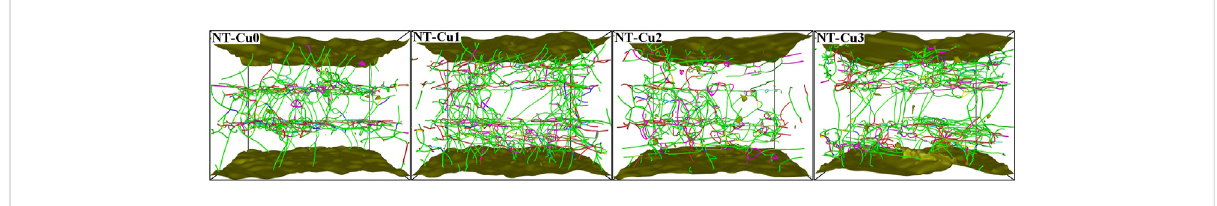
FIGURE 5 Images of the dislocations in samples with 18.2% tensile true strain (a/6 < 112 > Shockley partial dislocations are colored in green, a/2 < 110 > Perfect dislocations are marked in blue, a/6 < 110 > Stair-rod dislocations are marked in pink and other dislocations are set in red).